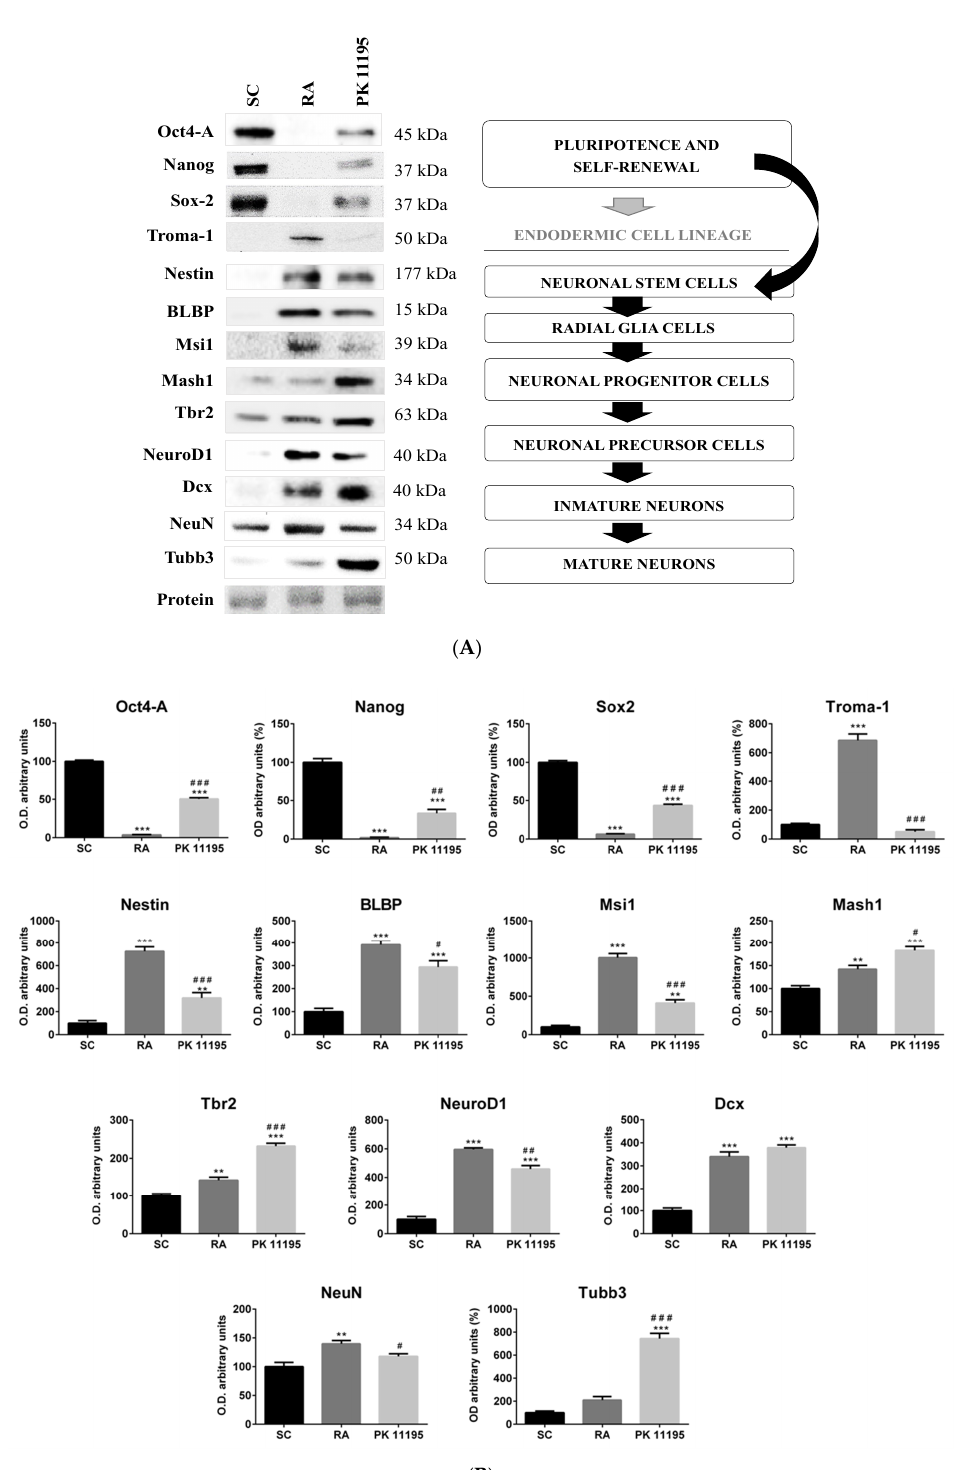
Figure 3. ( A ) Markers of pluripotency and neuronal differentiation in undifferentiated P19 stem cells (SC) and cells treated with 1 μ M retinoid acid (RA) or 50 μ M PK 11195 (PK 11195) during 4 days of treatment. ( B ) Bar chart shows quantification of the optical densities (OD) from three independent cell cultures and treatments. Data are expressed as means ± SEM. * p < 0.05 versus SC; ** p < 0.01 versus SC; *** p < 0.001 versus SC; # p < 0.05 versus RA; ## p < 0.01 versus RA; ### p < 0.001 versus RA. Protein shows a representative ponceau staining of one of the experiments. The complete ponceau staining for each antibody is shown in the Supplementary Figure S1. Although the entire membrane of ponceau S was used for total protein normalization, only a representative section of the membrane is displayed in this image.